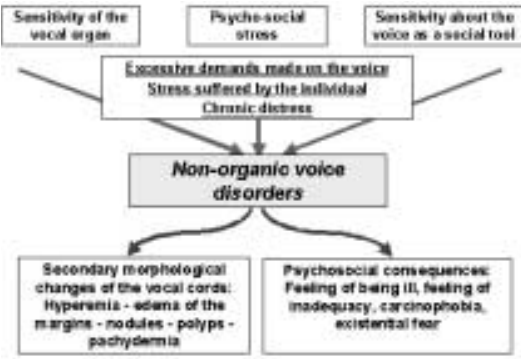
Aetiopathogenesis of non-organic voice disorders (modified from